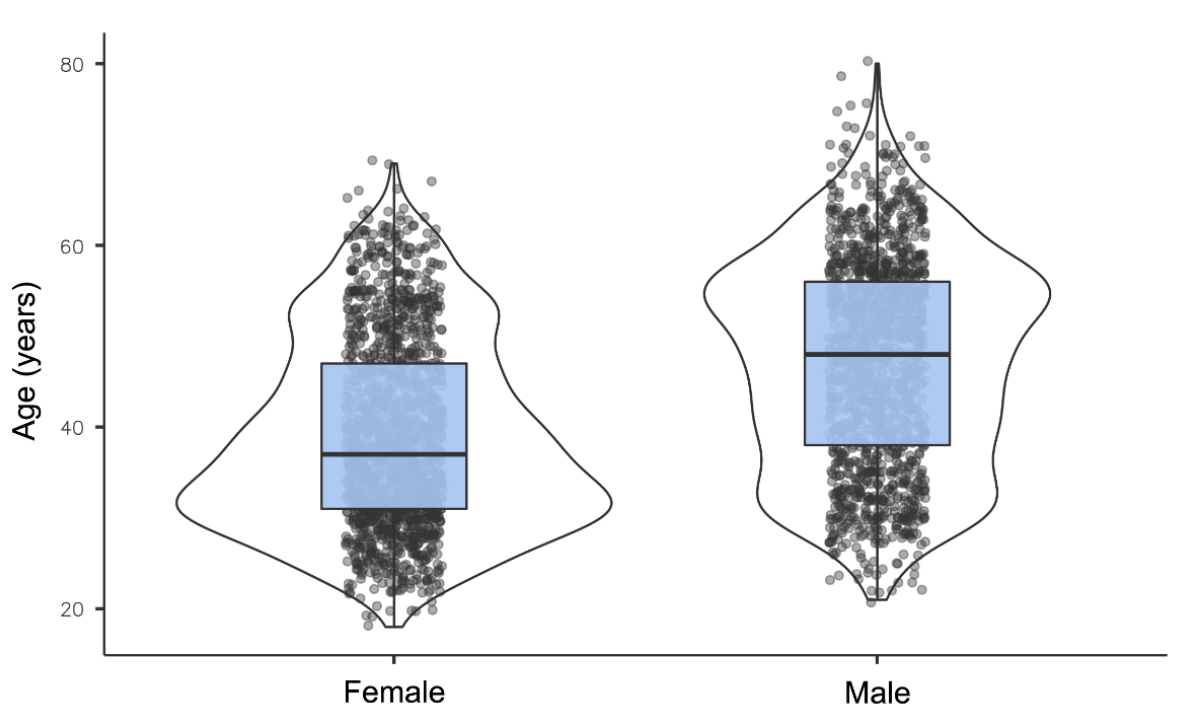
Figure 2. Age distribution split by gender within the study